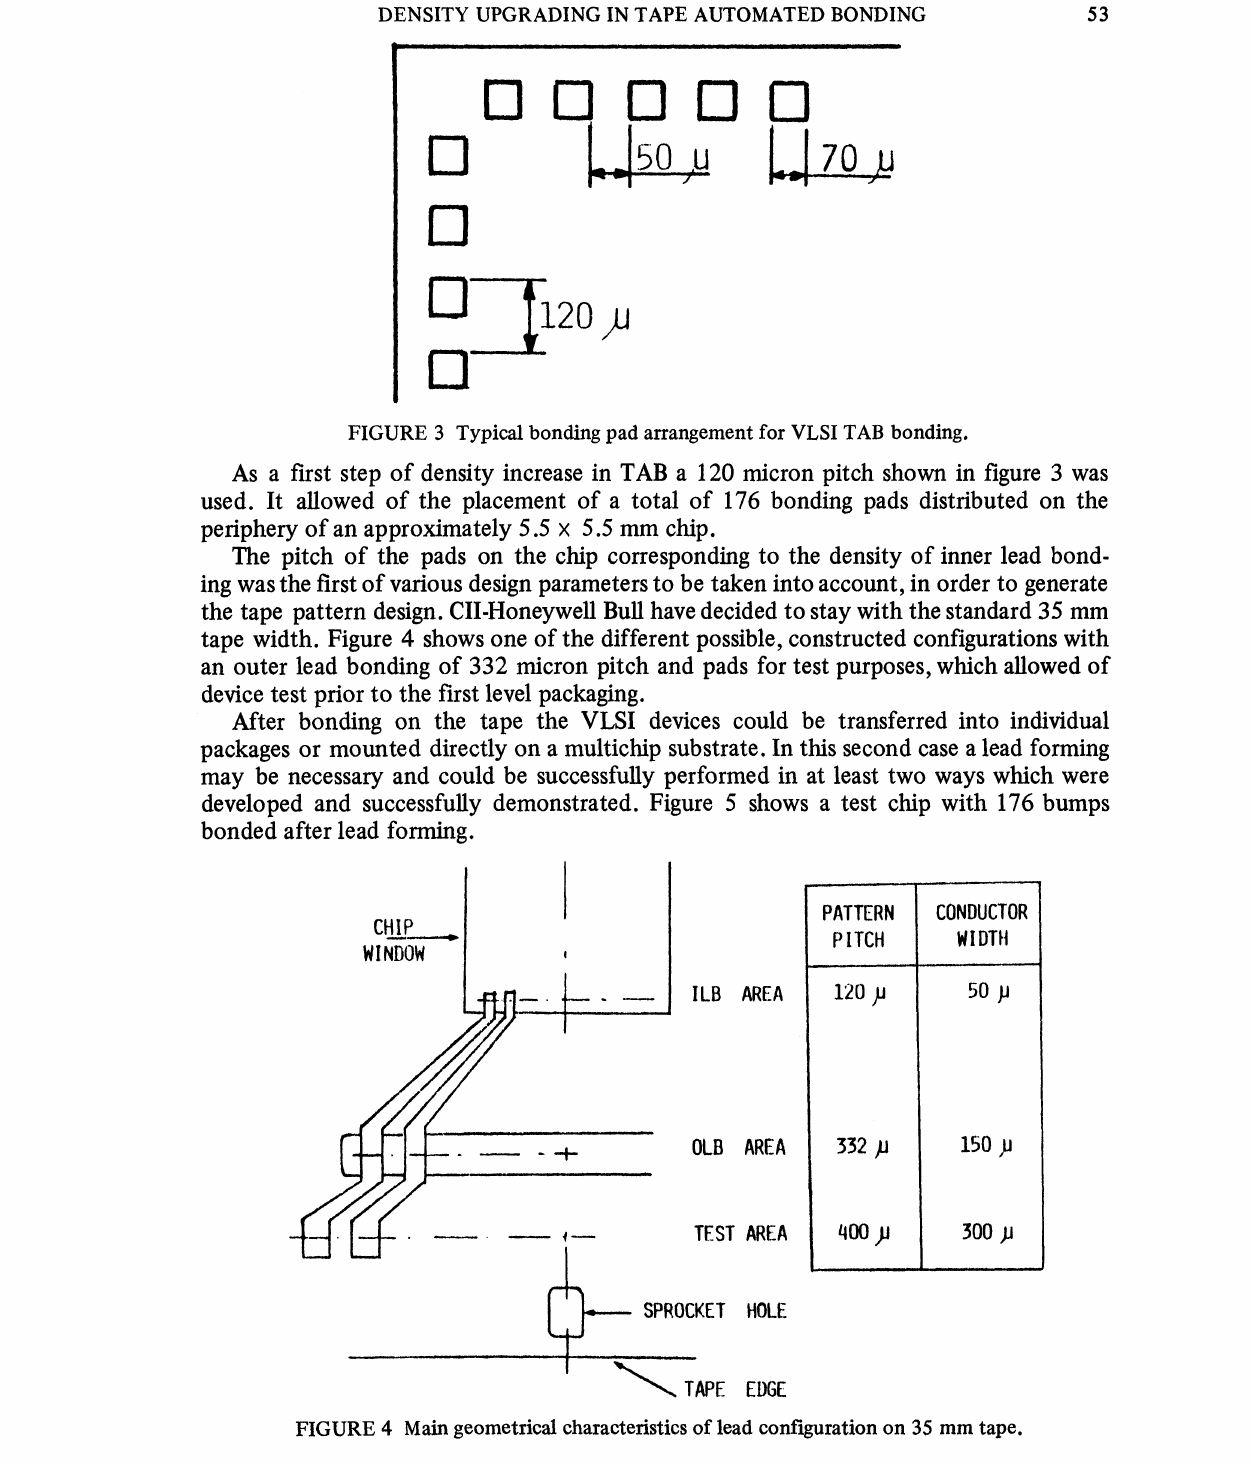
FIGURE 4 Main geometrical characteristics of lead configuration on 35 mm